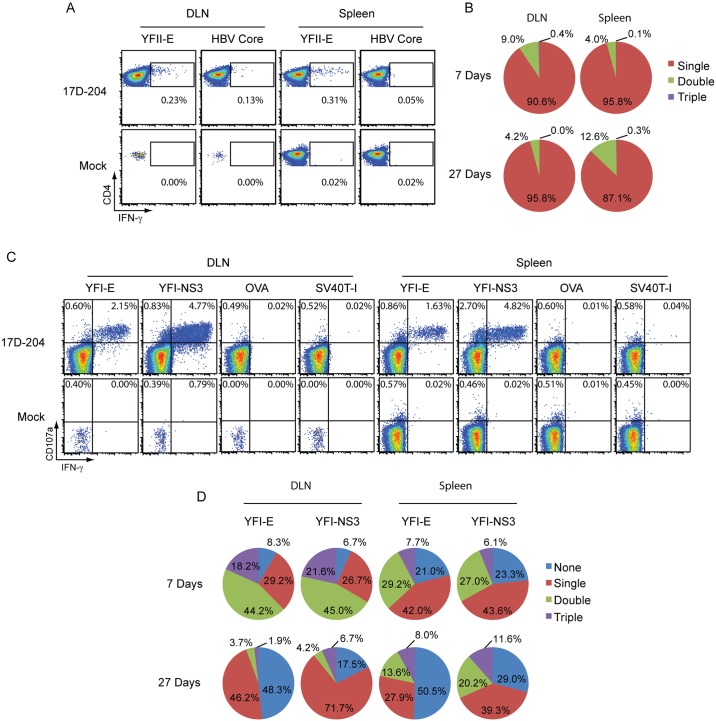
17D-204-specific T cells are polyfunctional.5–6 week old mice were immunized with 17D-204. On d7 or d27 post immunization DLNs and spleens were harvested and the intracellular cytokine response was measured for (A-B) CD4+ T cells responding to in-vitro restimulation with the YFII-E peptide and (C-D) CD8+ T cells responding to in-vitro restimulation with YFI-E and YFI-NS3 peptides. Total CD4+ T cells were grouped by their ability to respond by producing multiple cytokines; (A-B) IFNγ, TNFα and IL-4 [Single, Double, or Triple]. CD8+,CD107a+ T cells (C-D) were grouped by their ability to produce IFNγ, TNFα and IL-2 [None, Single, Double, or Triple]. The results are representative of two experiments (n = 3 mock, n = 6 17D-204). A and C are representative dot plots. Percentages in A and C are percent of total CD4+ (A) or total CD8+ (C) cells. B and D display the mean percentages across all samples.